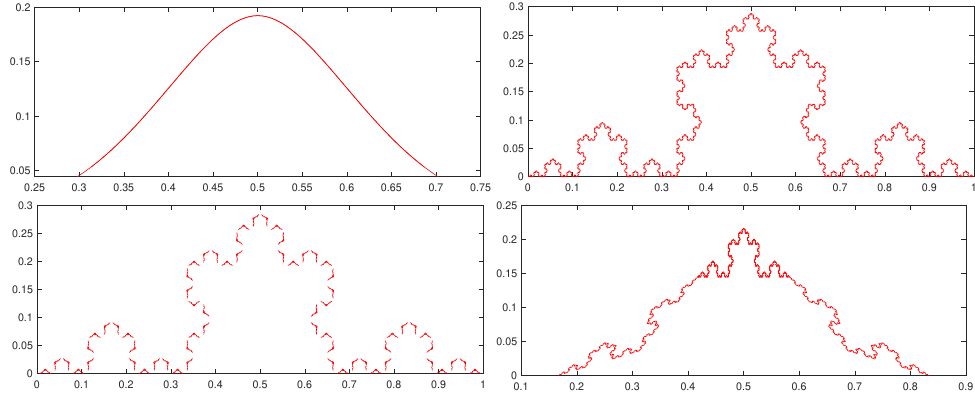
Figure 6. Attractors generated by the multiple-function system F 3 (cid:101) with (cid:101) = ( 0,0,0,0,0 ) , (1,1,1,1,1), (1,0,1,1,1), (1,1,1,1,0) (from left to right and top to